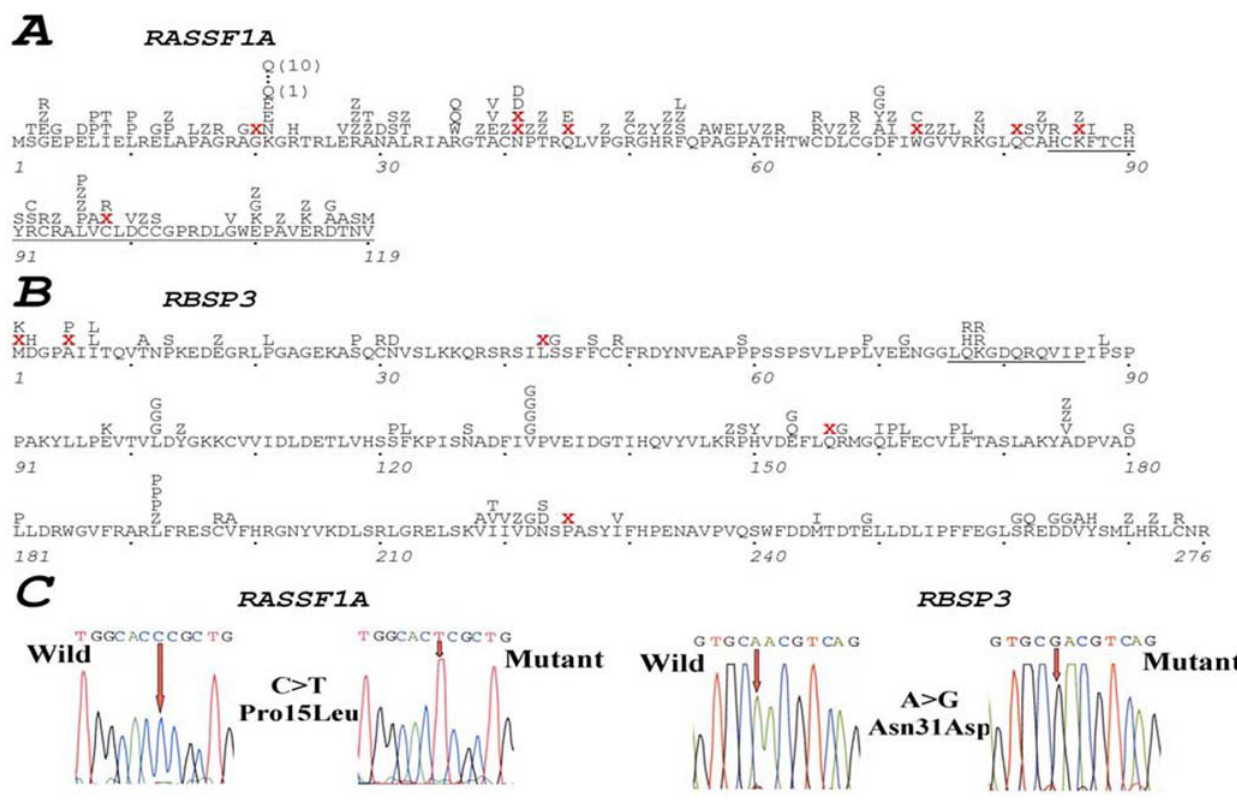
Figure 1. Mutations in RASSF1A and RBSP3 in natural and experimental tumors. Position of mutations detected in RASSF1A and RBSP3 is shown in A and B respectively. Examples of mutations are shown in C. For RASSF1A only mutations in coding sequences of exons 1 and 2 are shown. Mutations in the whole coding part of RBSP3 are shown. Red ‘‘X’’ marks stop nonsense mutations or deletions. ‘‘Z’’ designates synonymous mutations.